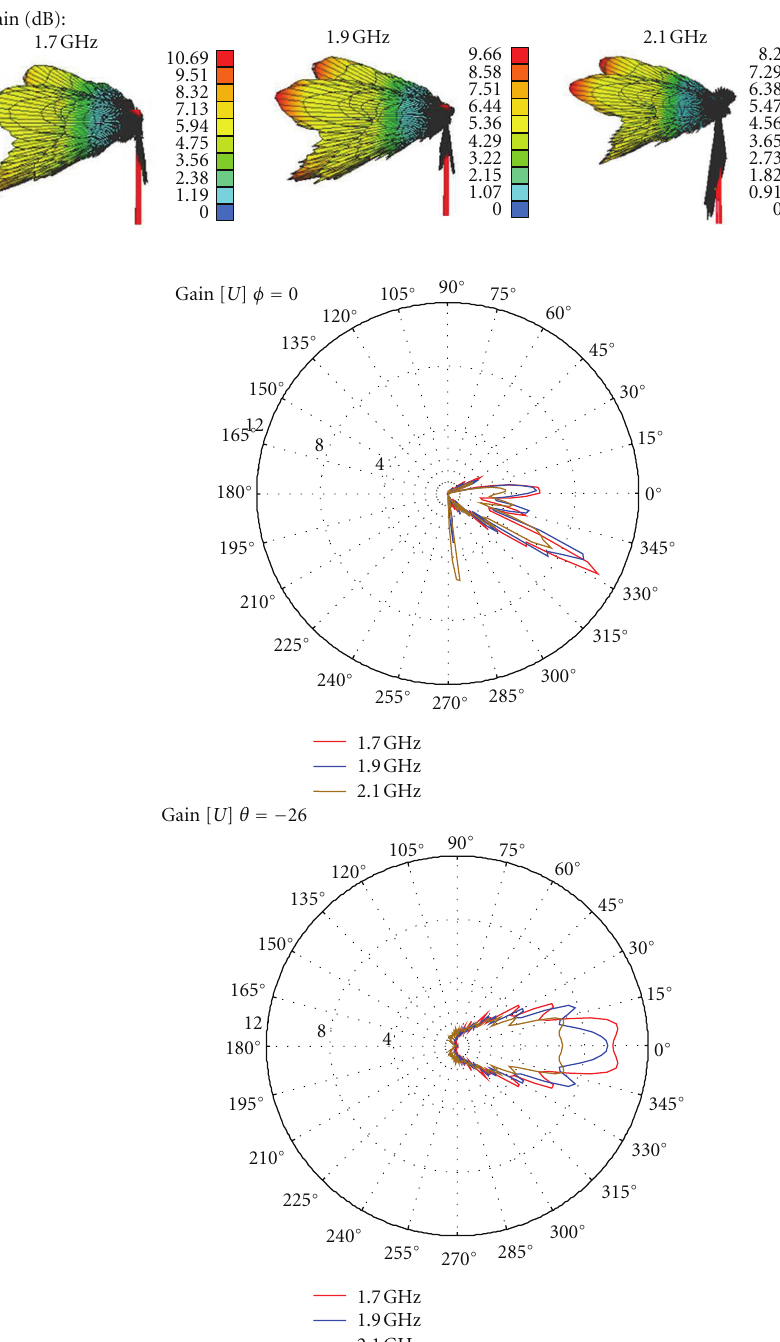
Figure 24: Radiation patterns for one realization in the lamppost